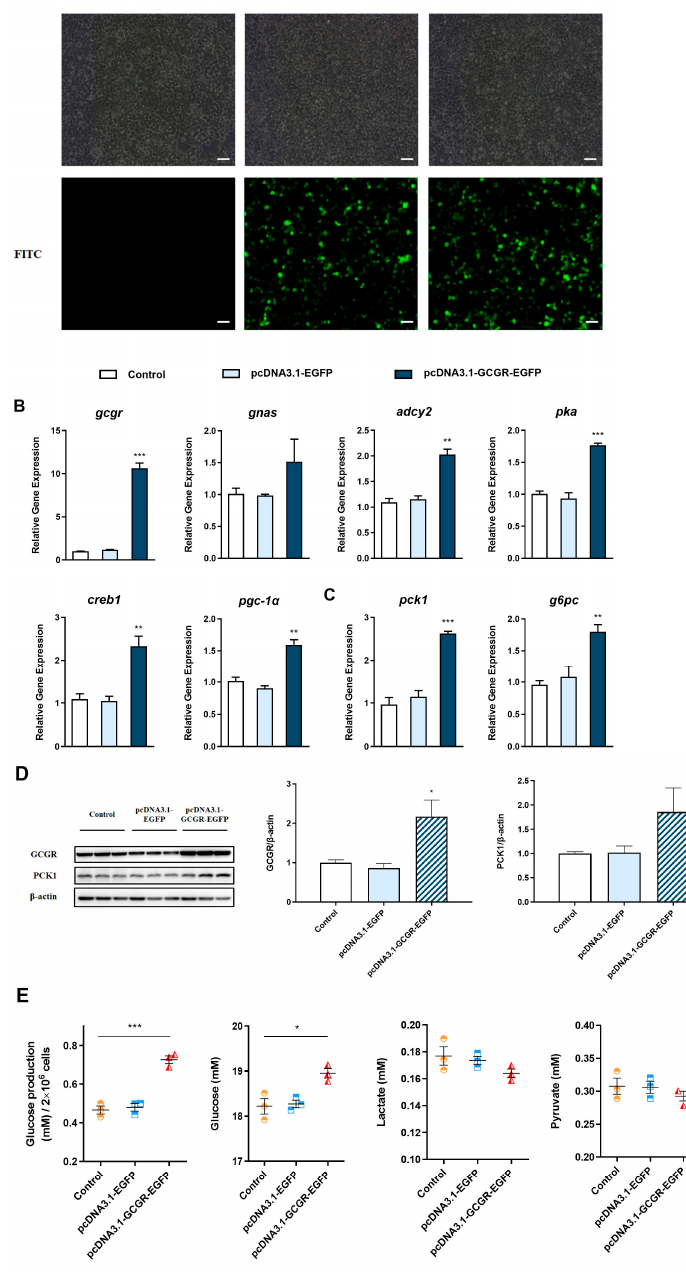
Figure 5. Overexpression of gcgr activates the glucagon pathway in hepatocytes. ( A ), Images of hepatocytes 48 h after transfection; bar = 100 µm. The cells were treated with PBS and transfected with the pcDNA3.1-EGFP plasmid and the pcDNA3.1-GCGR-EGFP plasmid. ( B ), qPCR analysis of the mRNA levels of glucagon pathway -elated genes ( gcgr ; gnas ; adcy2 ; pka ; creb1 ; pgc-1 α ) in hepatocytes treated with PBS and transfected with the pcDNA3.1-EGFP plasmid and the pcDNA3.1-GCGR-EGFP plasmid. ( C ), qPCR analysis of the mRNA levels of gluconeogenic genes ( pck1 and g6pc ) in hepatocytes treated with PBS and transfected with the pcDNA3.1-EGFP plasmid and the pcDNA3.1-GCGR-EGFP plasmid. ( D ), Western blot analysis of GCGR and PCK1 in hepatocytes treated with PBS and transfected with the pcDNA3.1-EGFP plasmid and the pcDNA3.1-GCGR-EGFP plasmid. ( E ), Glucose production in hepatocytes and glucose, lactate, and pyruvate concentrations in the medium following treatment with PBS and transfection with the pcDNA3.1-EGFP plasmid and the pcDNA3.1-GCGR-EGFP plasmid. All data are expressed as mean ± SE, n = 3, two-tailed t -test. * p < 0.05, ** p < 0.01, *** p < 0.001 versus PBS control.